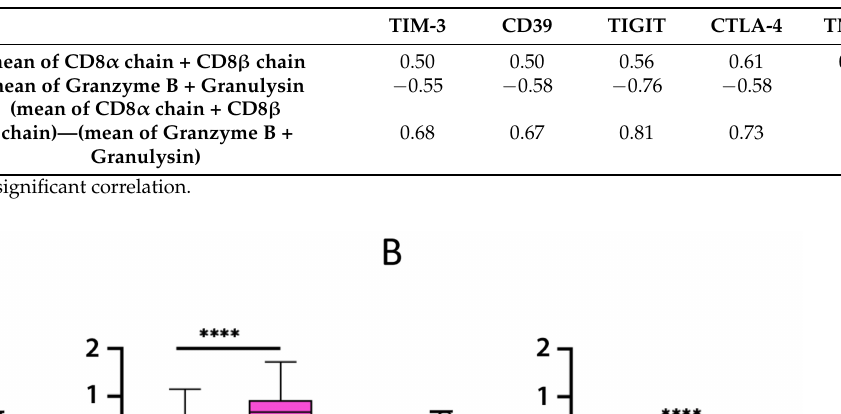
Table 2. Correlation (R) between normalized mRNA expression of selected genes and CD8 markers.